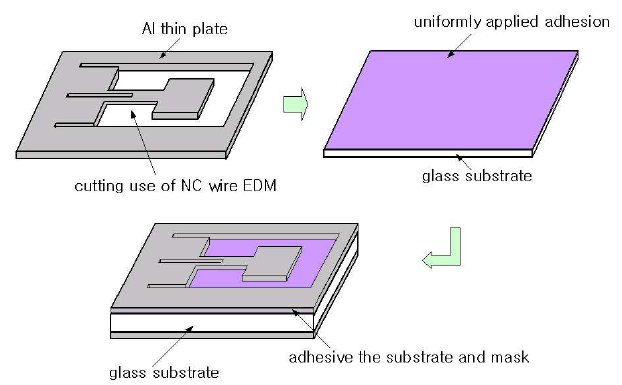
Figure 8. Performed masking process.